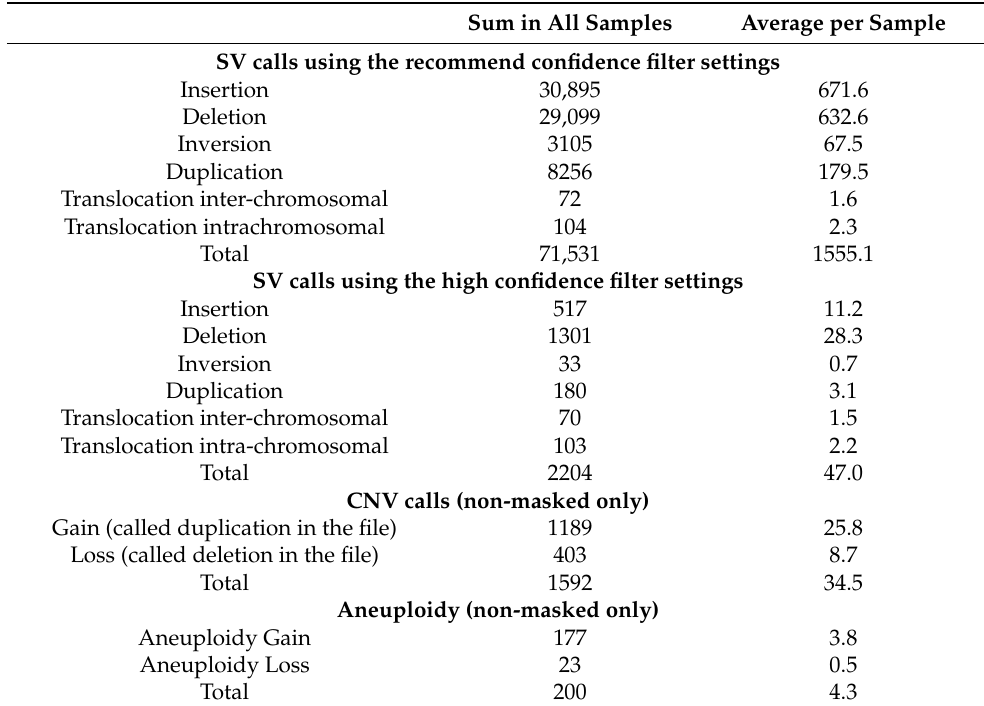
Table 1. SVs and CNVs calling in OGM.